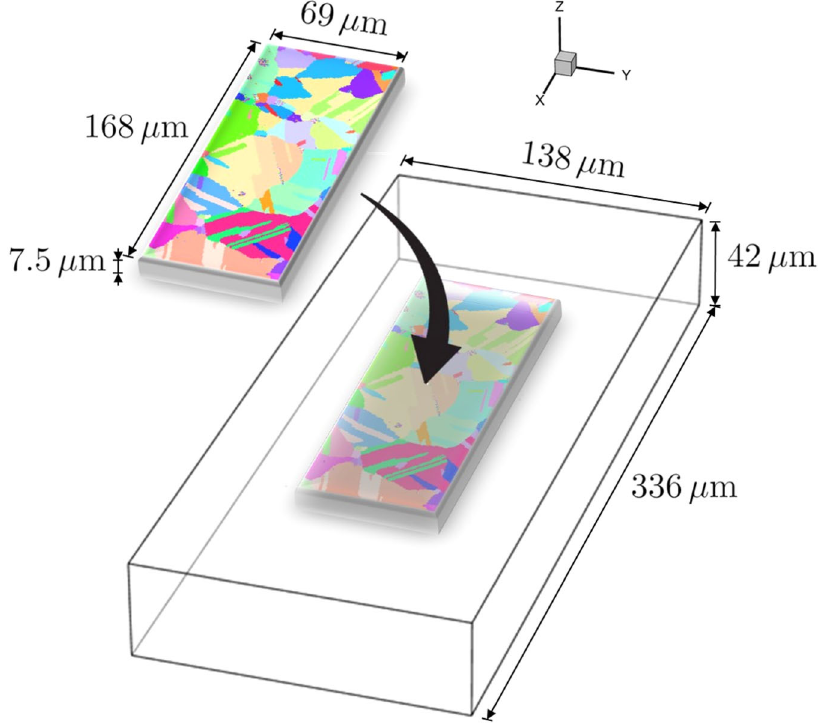
Fig. 7 Schematic of the concurrent computational domain. Microstructural RVEs are embedded in homogenized exterior domains.